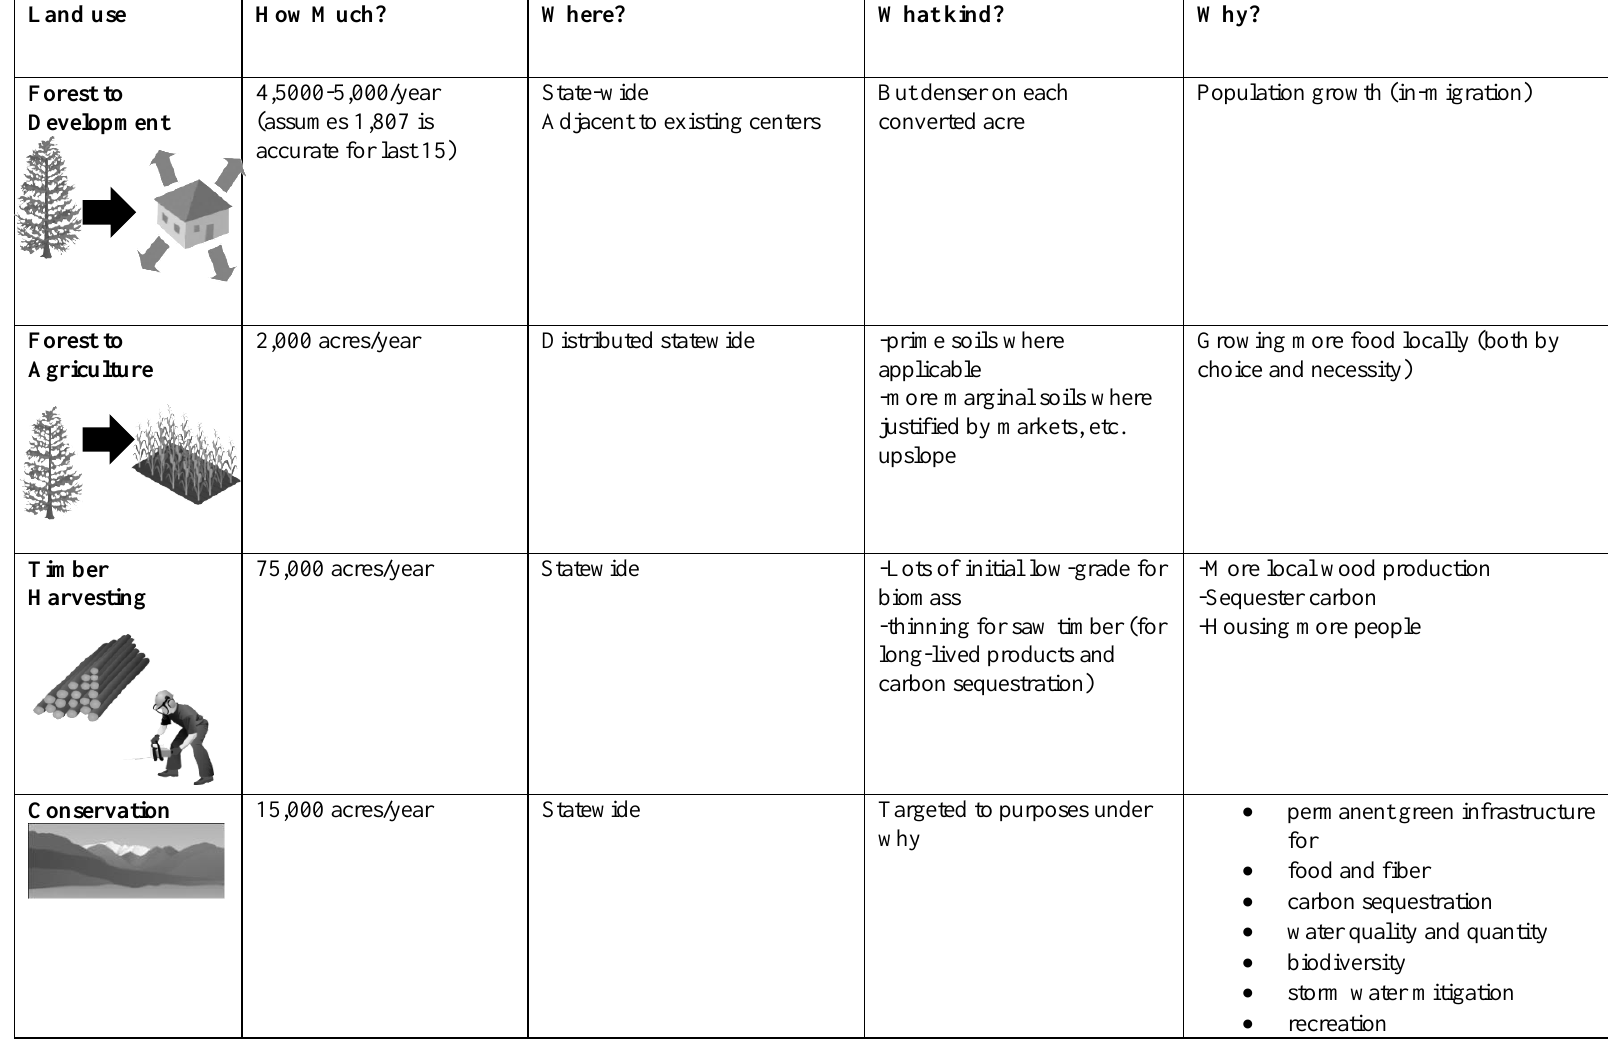
Table A2.23. Scenario 3: Smart Growth at Last Land